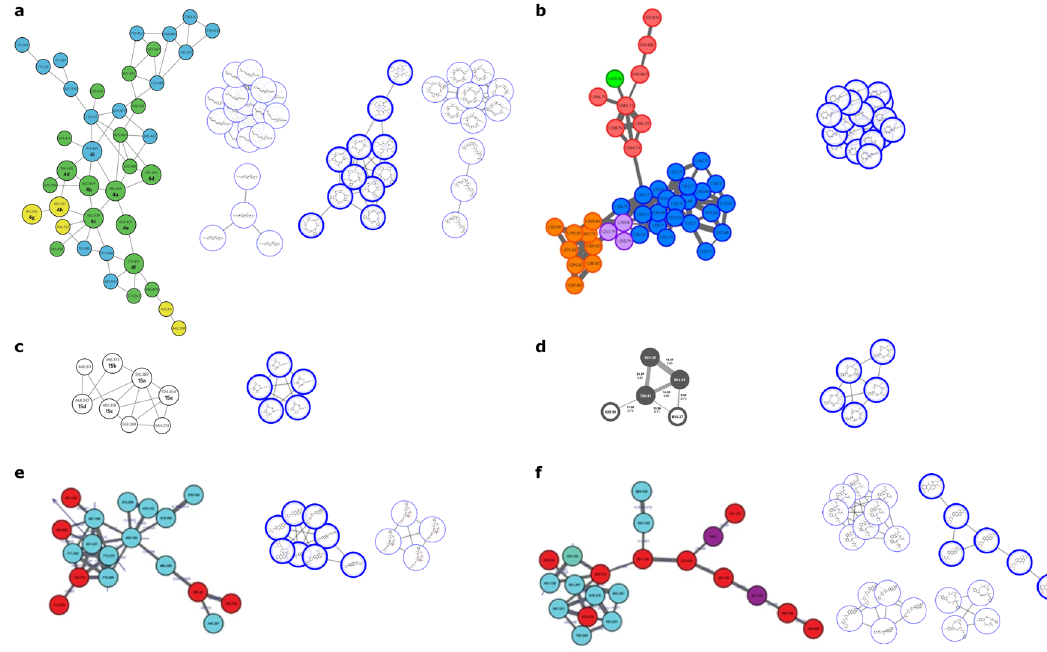
Fig. 6 | SNAP-MS analysis on published GNPS subnetworks. Reproductions of subnetworks from recently published data and their corresponding compound family annotations generated by SNAP-MS for a GameXPeptides b cyclic